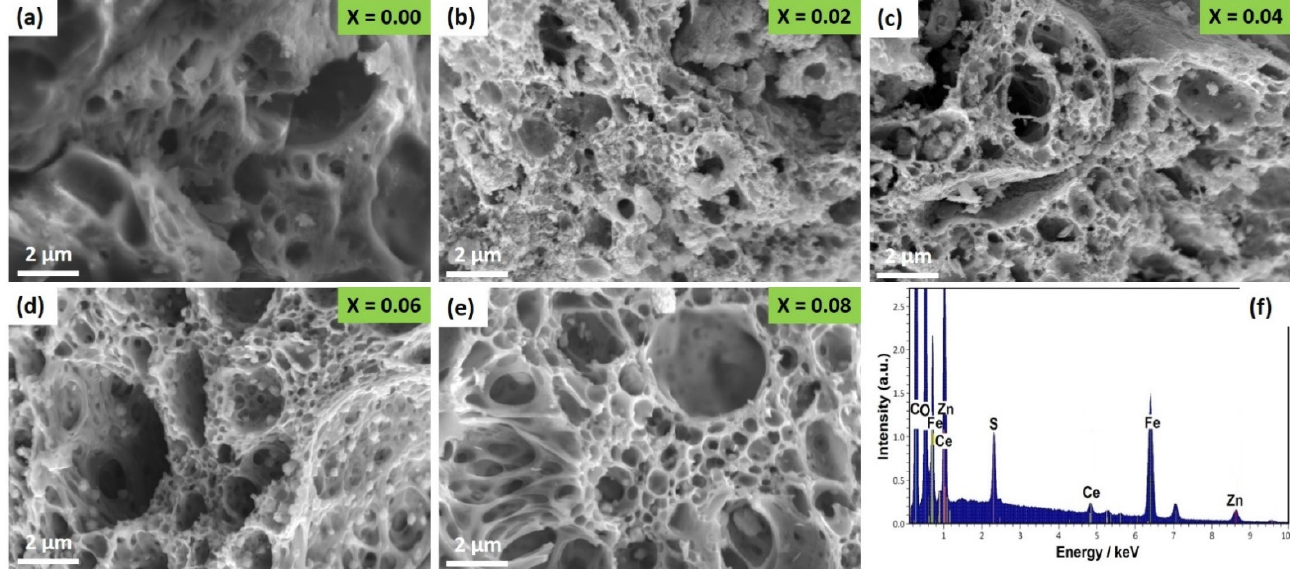
Figure 3. Surface morphology and elemental analysis where ( a ) SEM images of ZnCe x Fe 2 − x O 4 NPs ; X = 0.0, ( b ) X = 0.02, ( c ) X = 0.04, ( d ) X = 0.06, ( e ) X = 0.08), and ( f ) EDX analysis of ZnCe x Fe 2 − x O 4 NPs.